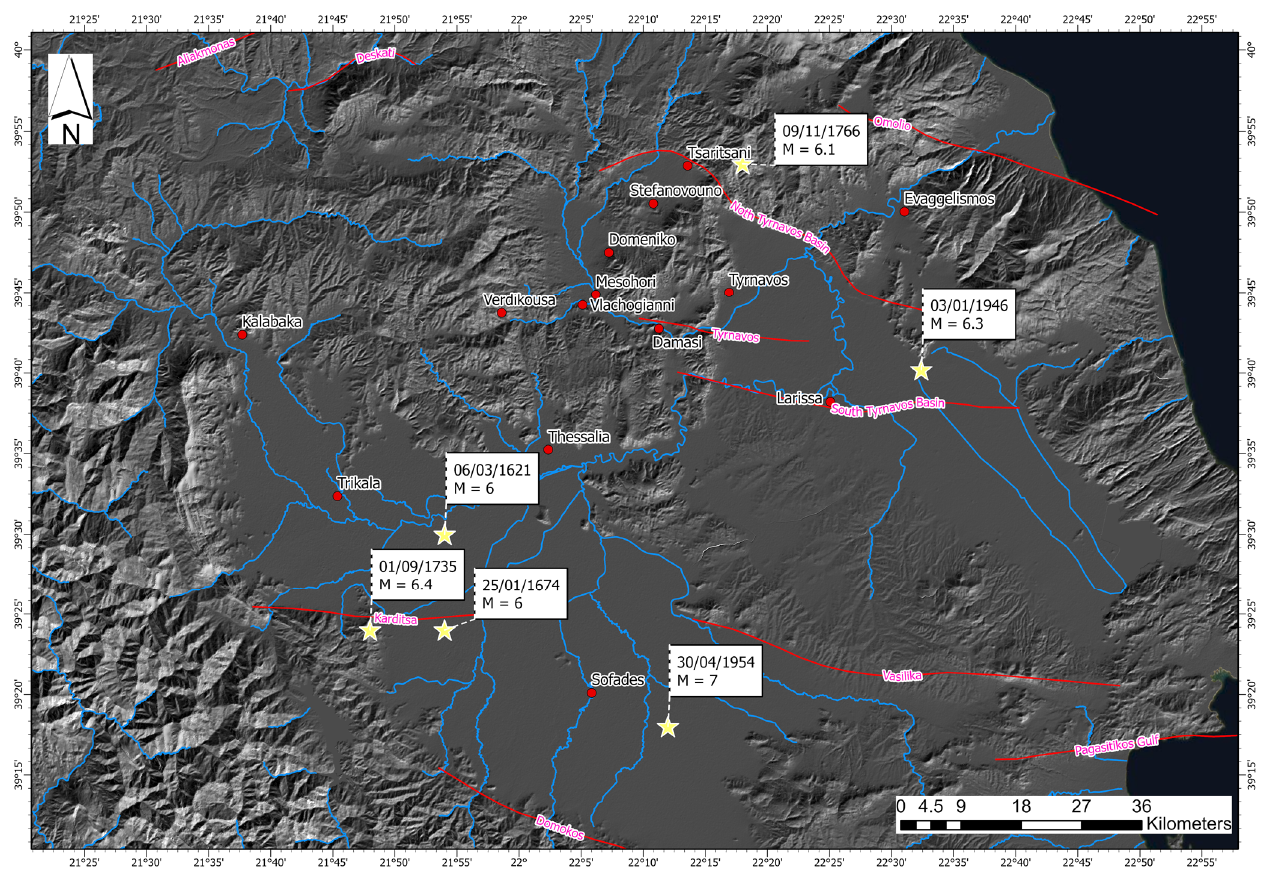
Figure 1. General structure map of Thessaly. The red circles represent the prefectures; red lines indicate the main active faults for the study area; the six yellow stars indicate the historical earthquake in the broader area of Thessaly; the blue lines represent rivers.